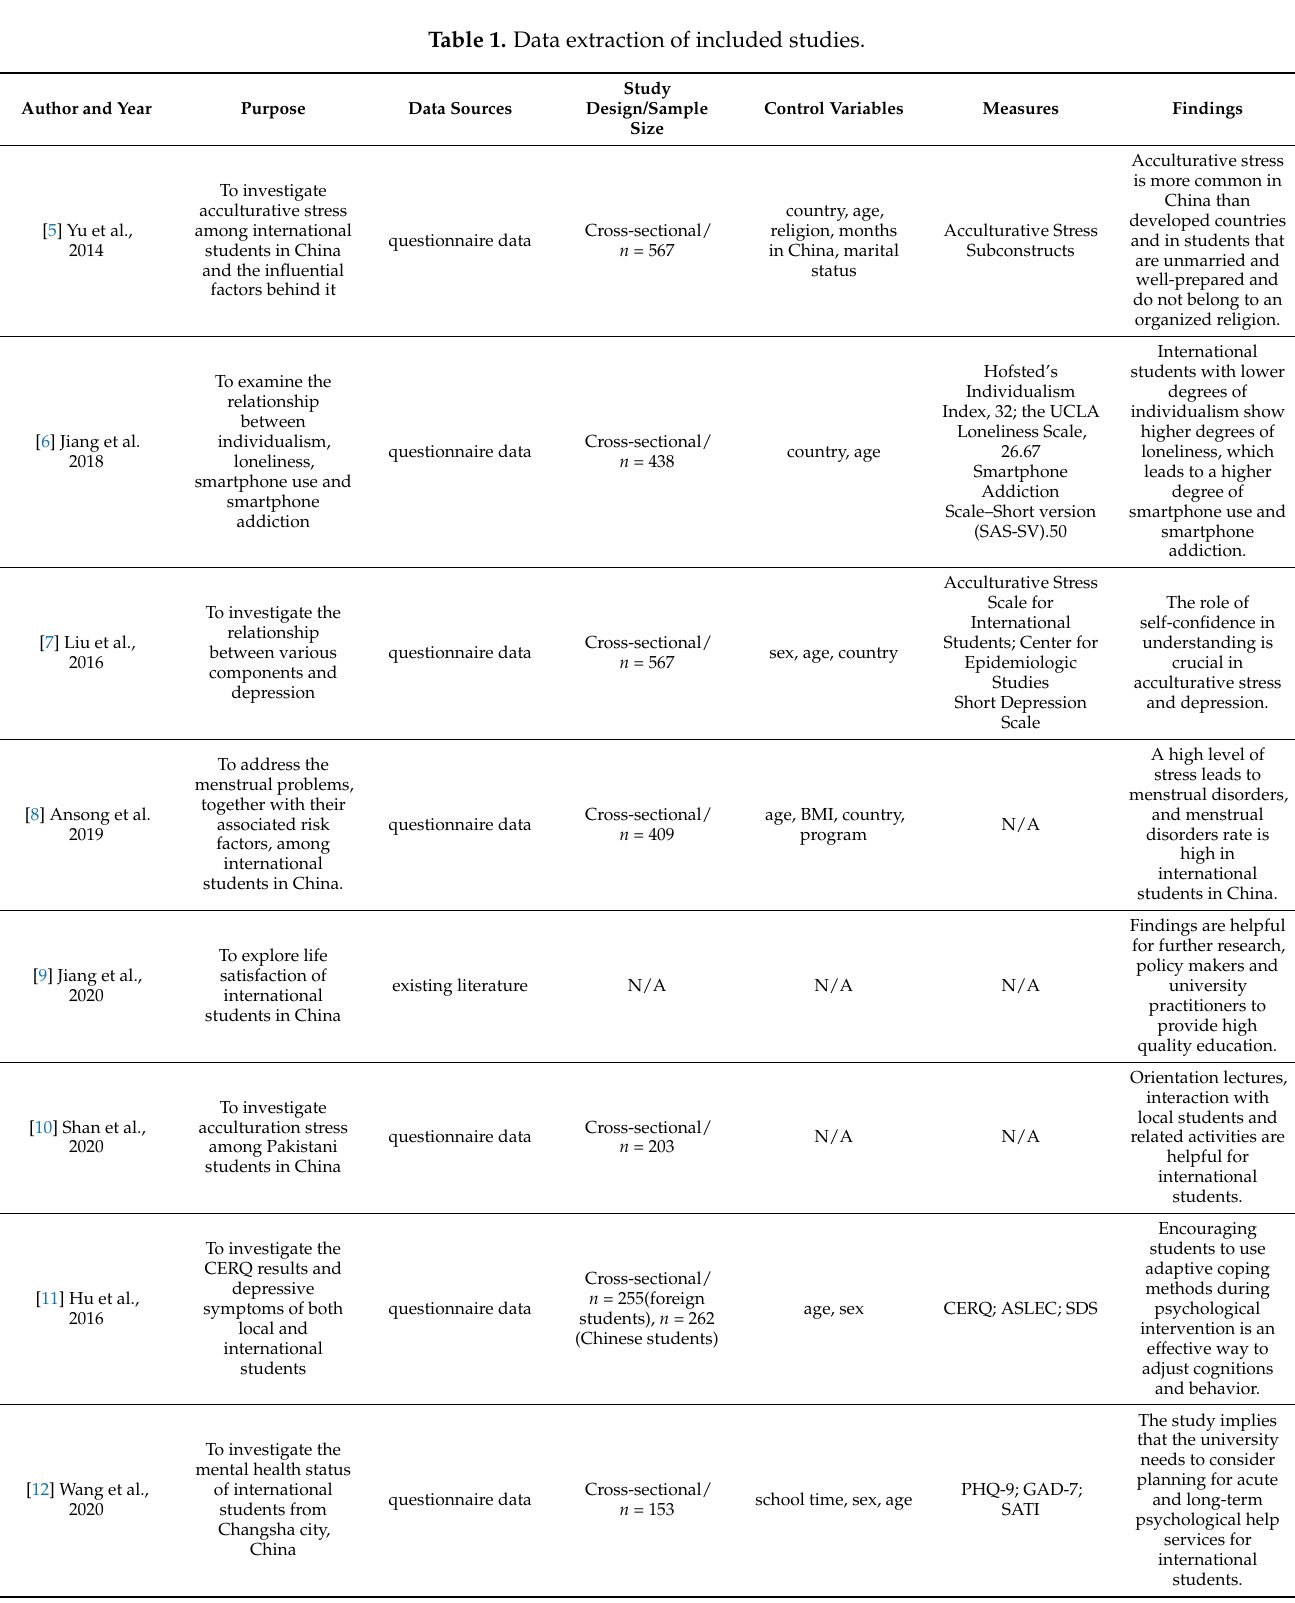
Table 1. Data extraction of included